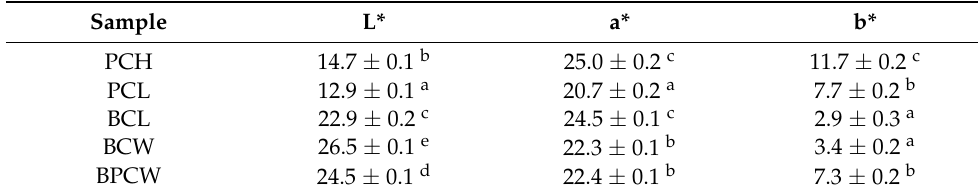
Table 4. Color parameters of